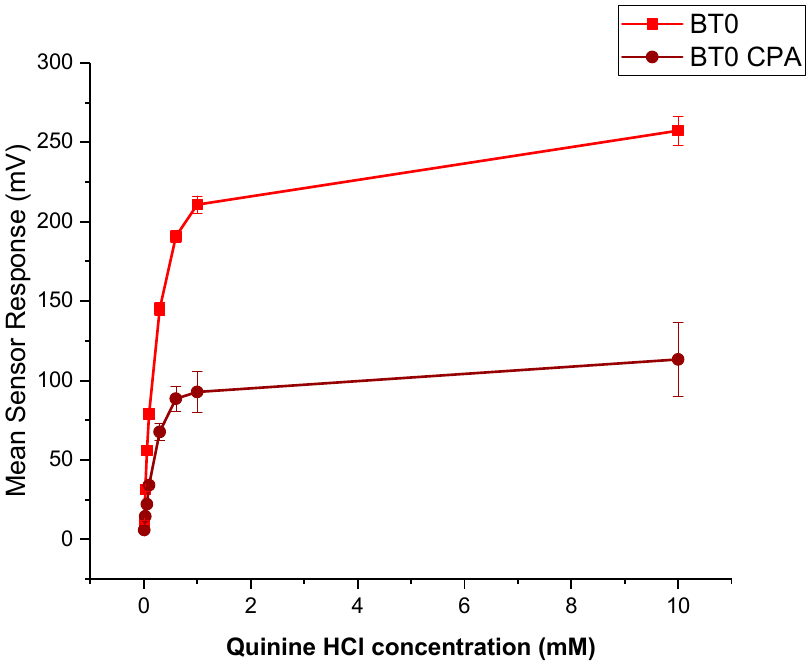
Figure 13. Dose–response curve representing initial taste and aftertaste (CPA) for quinine HCl dihydrate as detected by BT0 sensor.